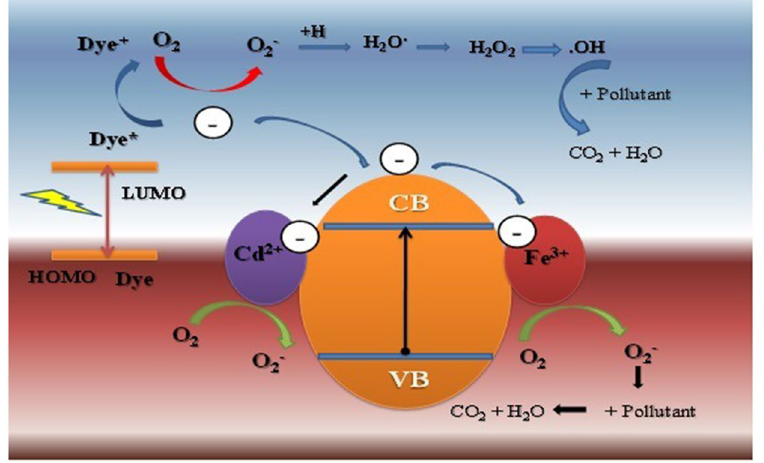
Figure 6. Schematic diagram for the charge separation and transfer of the photocatalysts under visible light